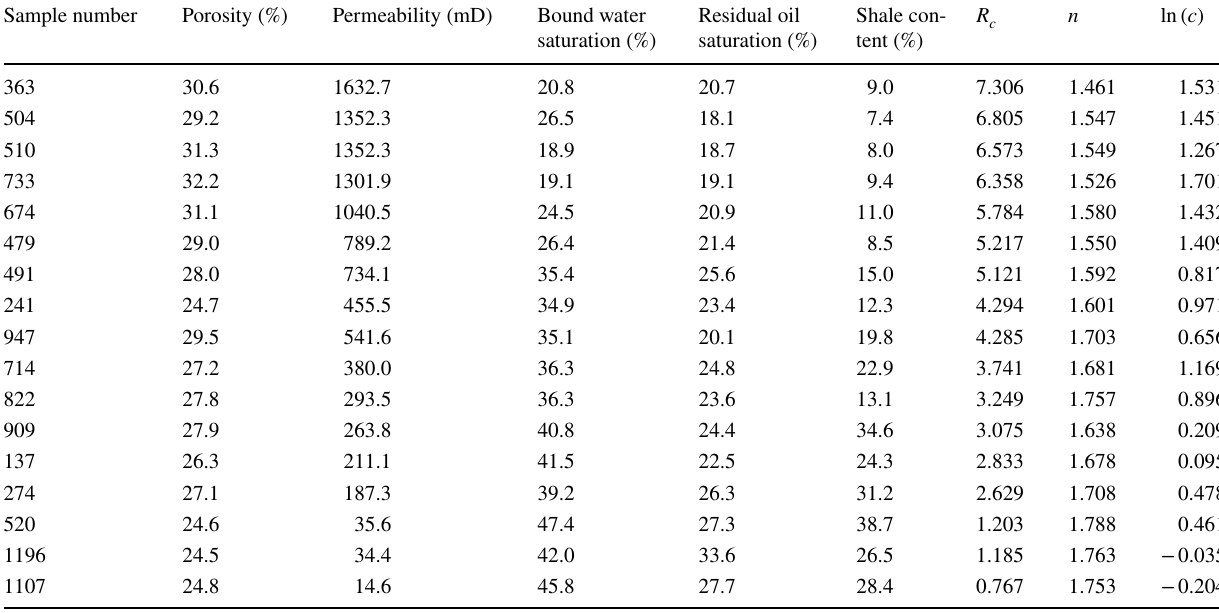
Table 3 Experimental parameters of different samples and the values of ln ( c ) and n Sample number